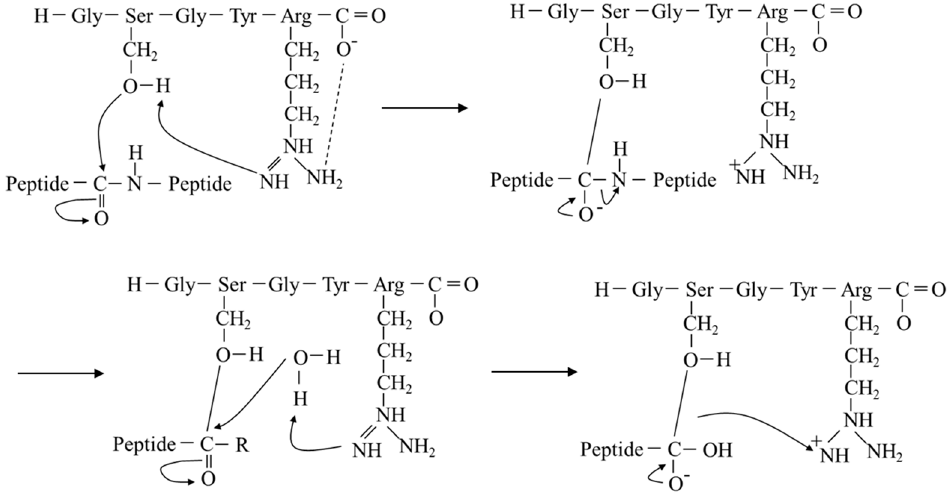
Figure 2. Proposed cleavage mechanism of